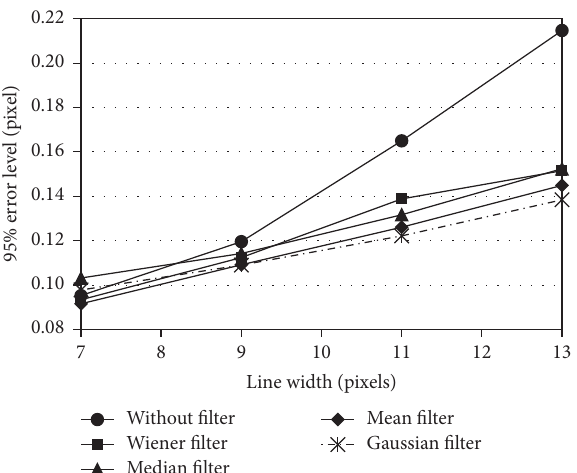
Figure 10: Displacement error levels with filtered undelayed and delayed images using different filters for image SNR F (or 1.6).